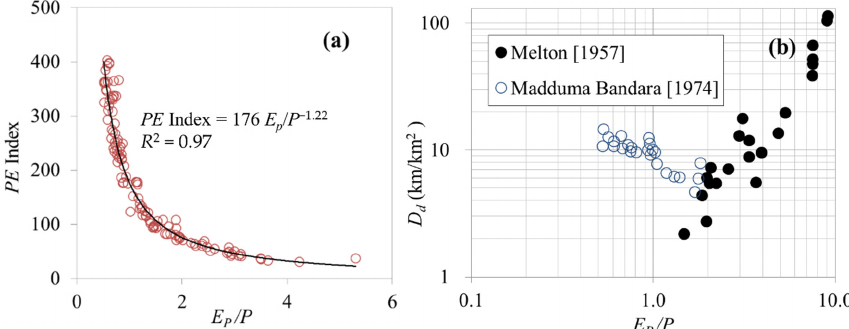
Figure 2. ( a ) The relationship ( PE = 176 E P / P − 1.22 ) between PE index and climate aridity index ( E P / P ) and ( b ) drainage density ( D d ) versus E P / P from Melton [32] and Madduma Bandara [38].